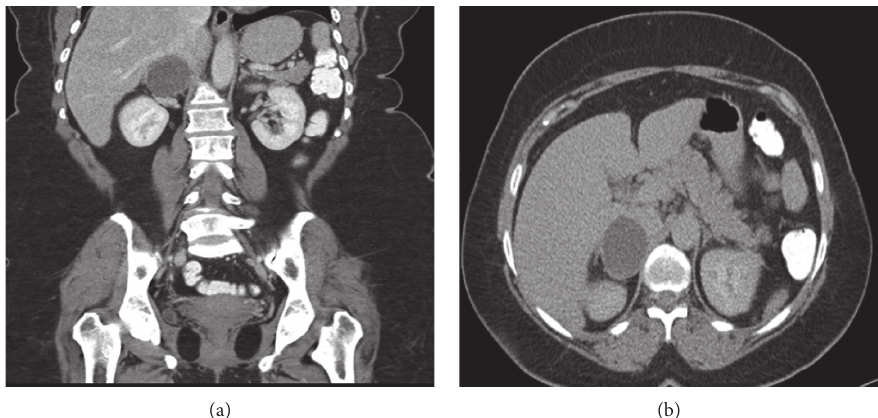
Figure 1: Preop CTadrenal: (a) coronal section and (b) axial section showed a 4.8 × 4.1cm well-defined rounded right adrenal hypodense lesion. It has precontrast density of 12HU. Its density measured 10HU in the porto-venous phase and 15HU on the delayed 15 minutes phase. No wall calcification. The left adrenal gland is within